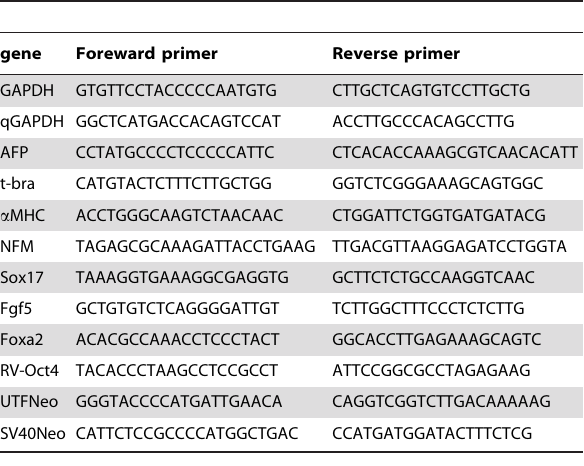
Table 1. Primers used for RT-PCR and proof of transgene